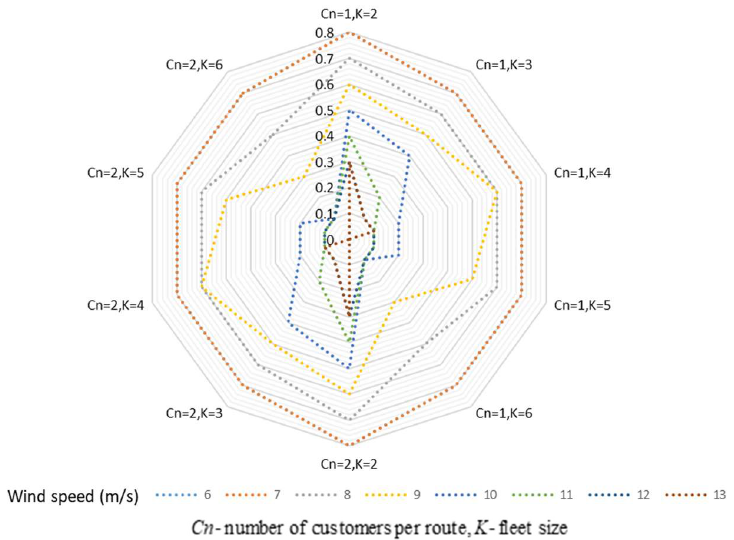
Figure 15. Customer satisfaction levels for the sub-missions created at different wind speeds.